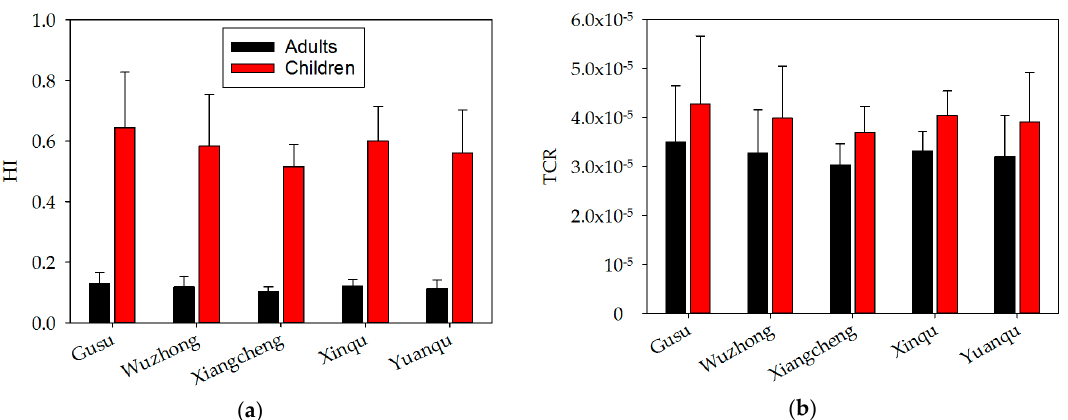
Figure 5. Hazard indices (HIs) ( a ) and total carcinogenic risks (TCRs) ( b ) of the metals in soil samples according to the sampled districts.